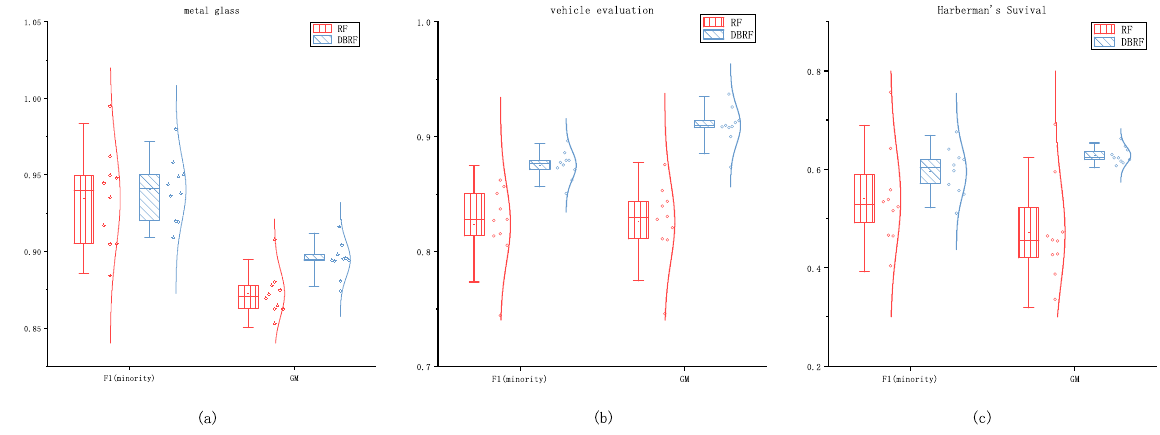
Figure 7. Box plot of 10-fold cross-validation on the on the ( a )metal glass, ( b ) vehicle evaluation, and ( c ) Harberman’s suvival with the best p and η